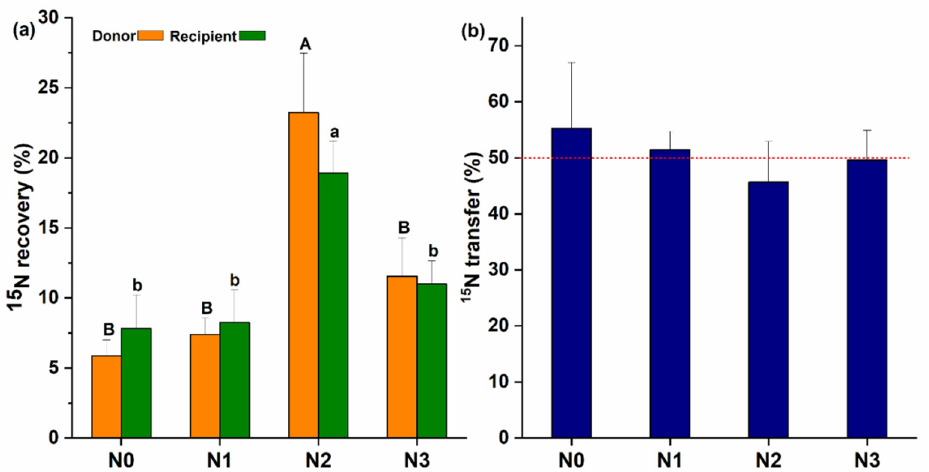
Figure 3. Role of common mycorrhizal networks (CMNs) in the recovery and transfer of 15 N; ( a ) the amount of 15 N uptake by mycelium and recovered in donor and recipient plants; ( b ) % of N 15 transfer from donor to recipient plant with help of the mycorrhizal networks. Capital letters show the difference between donor, and small letters are showing differences among recipient plants at different treatments (N0, N1, N2, and N3). Alphabetic on the top of each bar shows the LSD 0.05